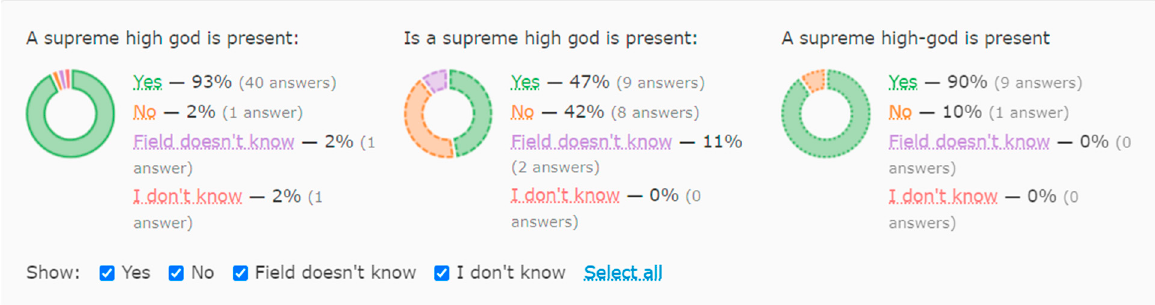
Figure 5. DRH visualization of the query “ A supreme high god is present” from 330–1204 CE focusing on the broader Mediterranean and Near East regions. The pie charts represent the “Group”, “Place”, and “Text” polls, ordered from left to right.